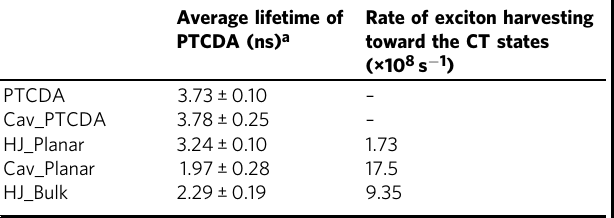
a The average lifetimes for all fi lms and cavities are calculated based on a three-exponential model convoluted with the instrument response function (IRF): < τ > = ∑ i τ 2 i B i = ð τ i B i Þ , where B i is the amplitude of the corresponding component. The error bars of the average lifetimes are obtained from the deconvolution fi tting of the